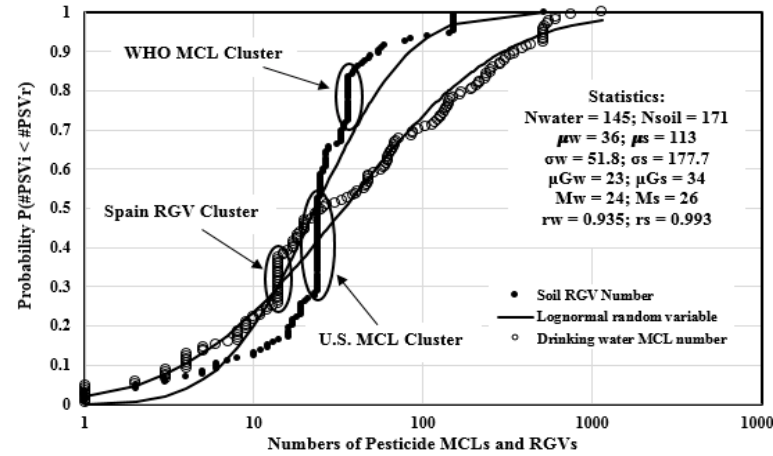
Figure 1. Empirical distributions of the number of worldwide regulatory guidance values (RGVs) and maximum concentration levels (MCLs) compared to the theoretical distribution of a lognormal random variables.